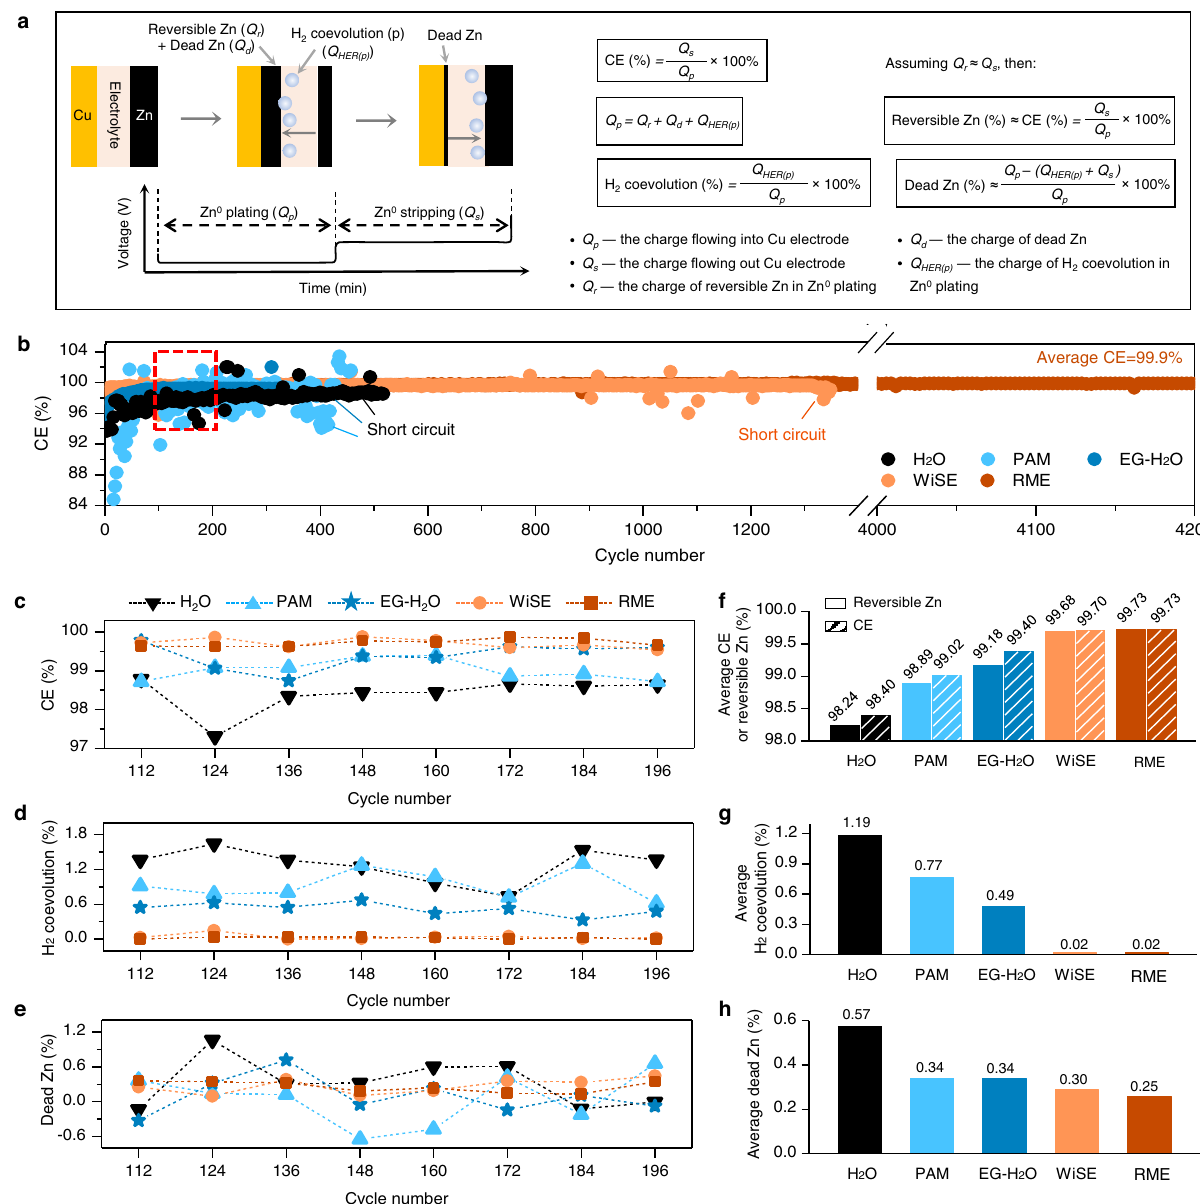
ofselectedcyclesinthe fi veelectrolytes.AverageCEandcontributionofreversible Zn( f ),averagecontributionofH 2 coevolution( g ),andaveragecontributionofdead Zn ( h ) in the fi ve electrolytes. The galvanostatic discharging and charging tests were conducted at current density of 0.8mAcm – 2 with areal capacity of 0.8mAh cm – 2 at